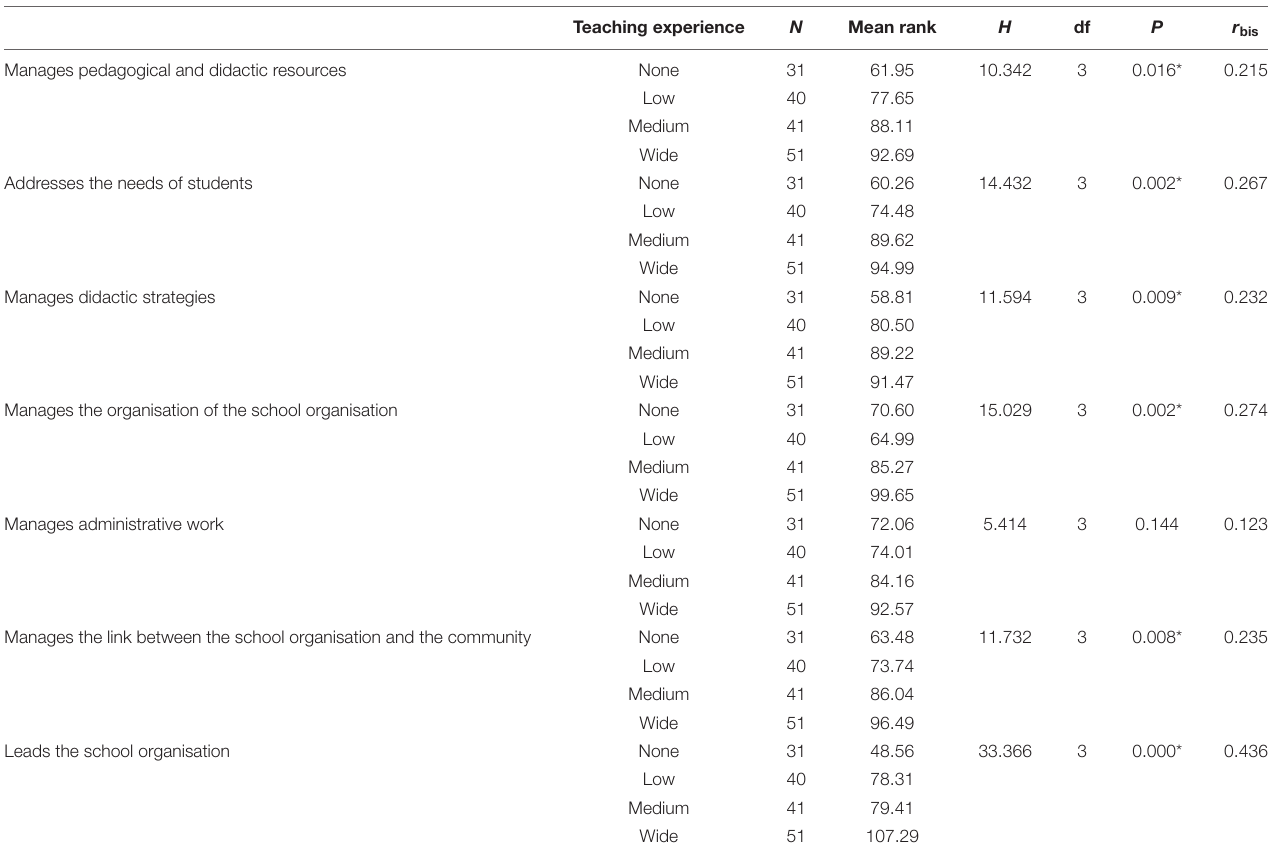
TABLE 6 | Results of Kruskal-Wallis H test level of teaching experience in